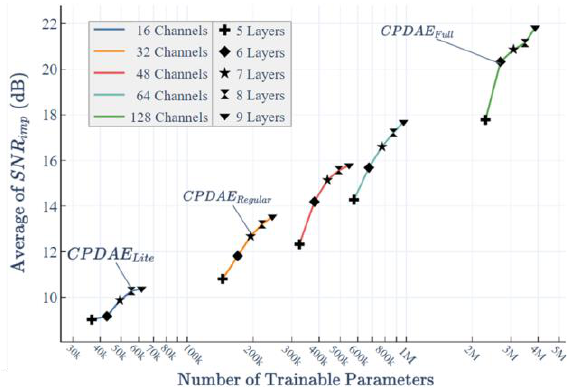
Figure 9. A performance comparison of CPDAE models with various channels and encoder/decoder layers.